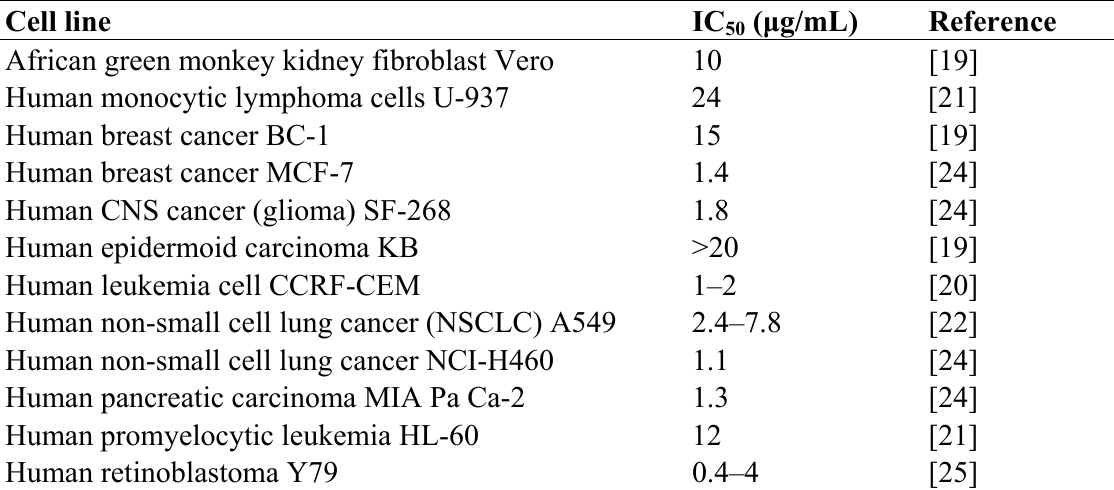
Table 1. The cytotoxicity of beauvericin.